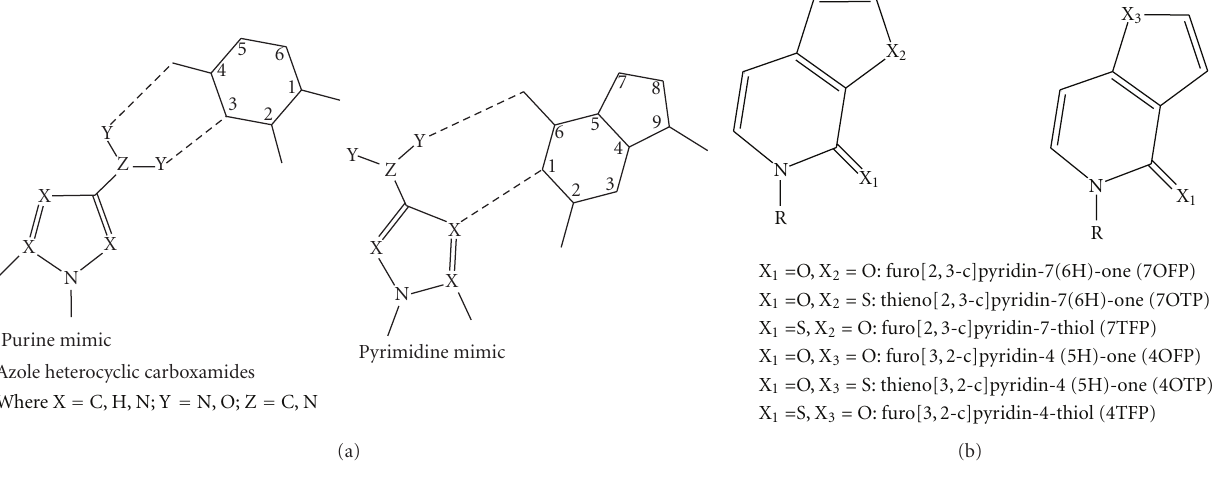
Figure 6: Classes of purine/pyrimidine mimics. (a) Skeleton structure of azole heterocyclic carboxamides. Depending on the position of the heteroatoms and their ability to donate or accept hydrogen bonds, these analogs can form base pairs with either a purine or a pyrimidine [91]. (b) General structure of the furo/thieno pyridinones; di ff erent heteroatoms in each position give the following compounds: furo[2,3-c]pyridin-7(6H)-one: 7OFP, thieno[2,3-c]pyridin-7(6H)-one: 7OTP, furo[2,3-c]pyridin-7-thiol: 7TFP, furo[3,2-c]pyridin-4(5H)- one: 4OFP, thieno[3,2-c]pyridin-4(5H)-one: 4OTP, furo[3,2-c]pyridin-4-thiol: 4TFP [86,